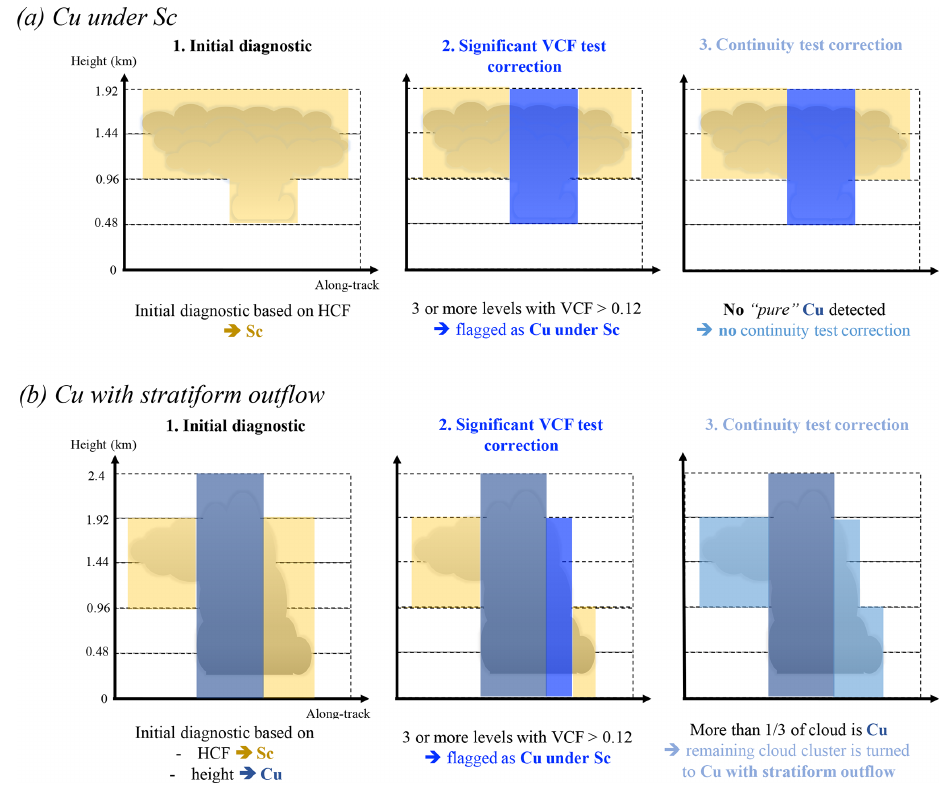
Figure 5. Illustration of the Cu and Sc mixed situations using additional diagnostics in the DA: (a) Cu under Sc and (b) Cu with stratiform outflow. After the DA diagnoses (1) an initial cloud type, the additional (2) significant VCF variability test and (3) horizontal continuity correction are applied to contiguous cloud clusters (see details in Sect. 3.4 and